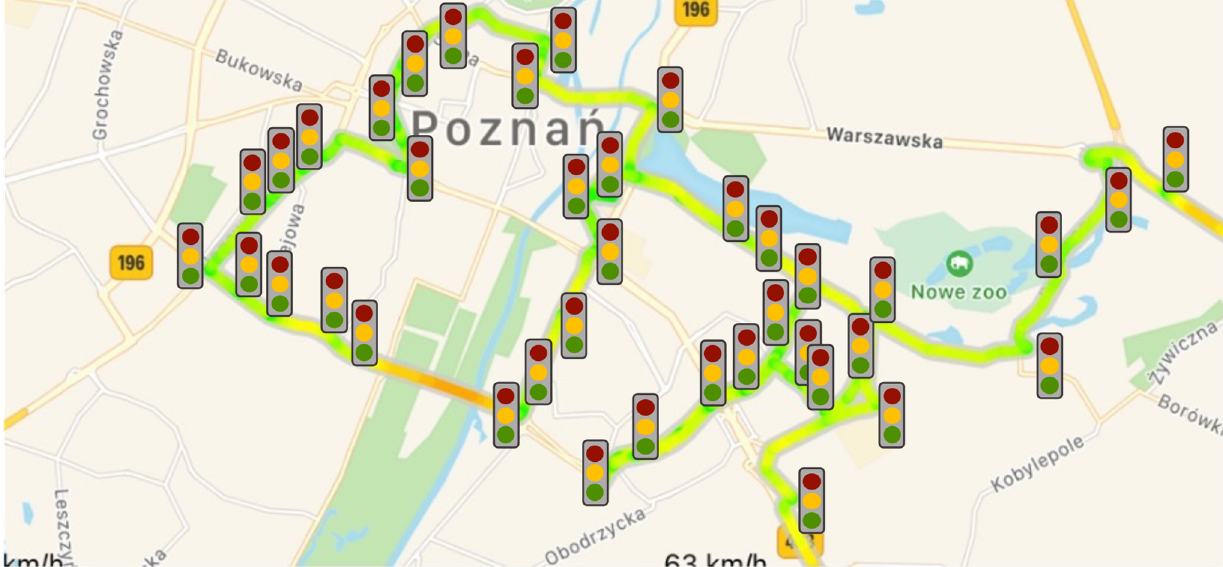
Figure 14. Stops enforced by the infrastructure in the urban section along the marked route.